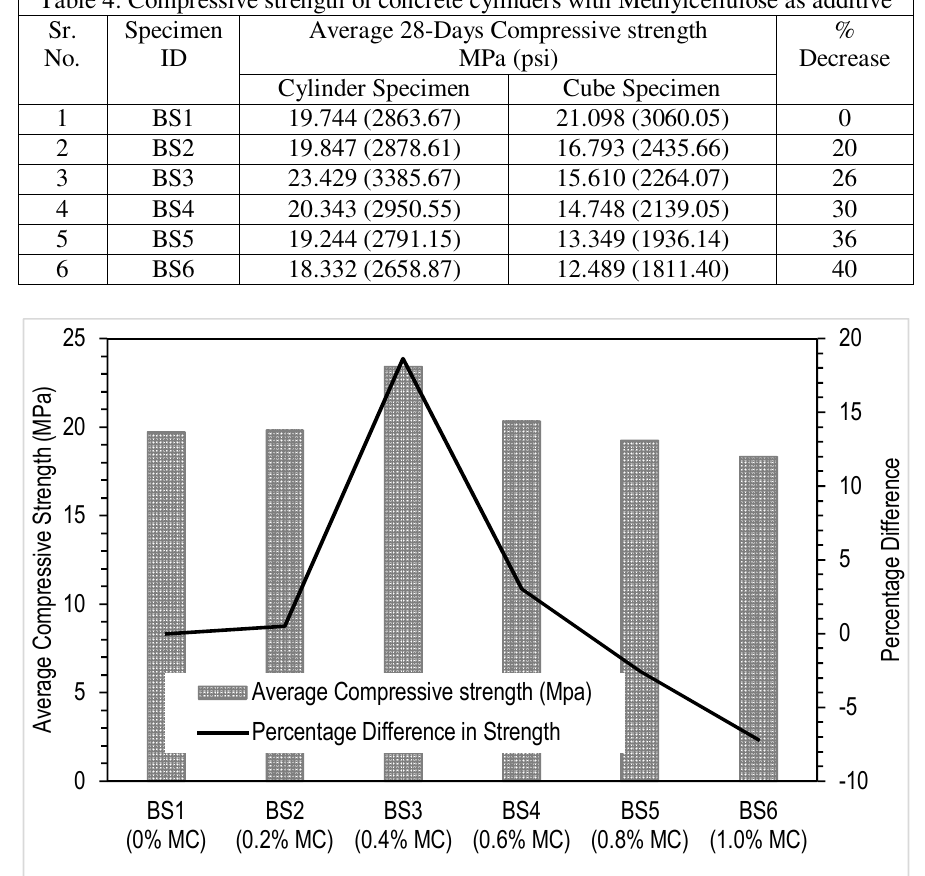
Fig. 6: Compressive strength of concrete cylinder specimens with 0%-1% MC content (1 MPa = 145.04 psi) Table 5: Compressive strength of cement mortar cubes Sr.